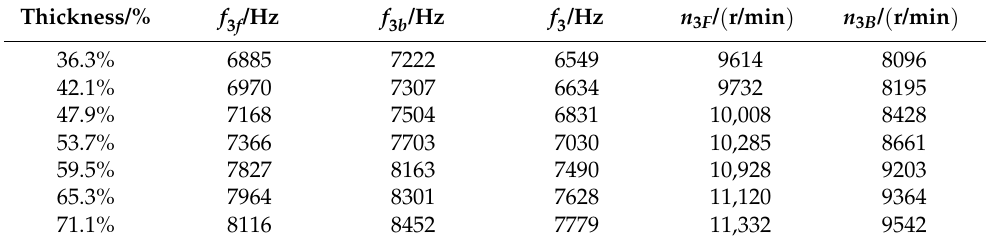
Table 9. The change of 3rd ND TWR speed at different thickness of spoke plate.